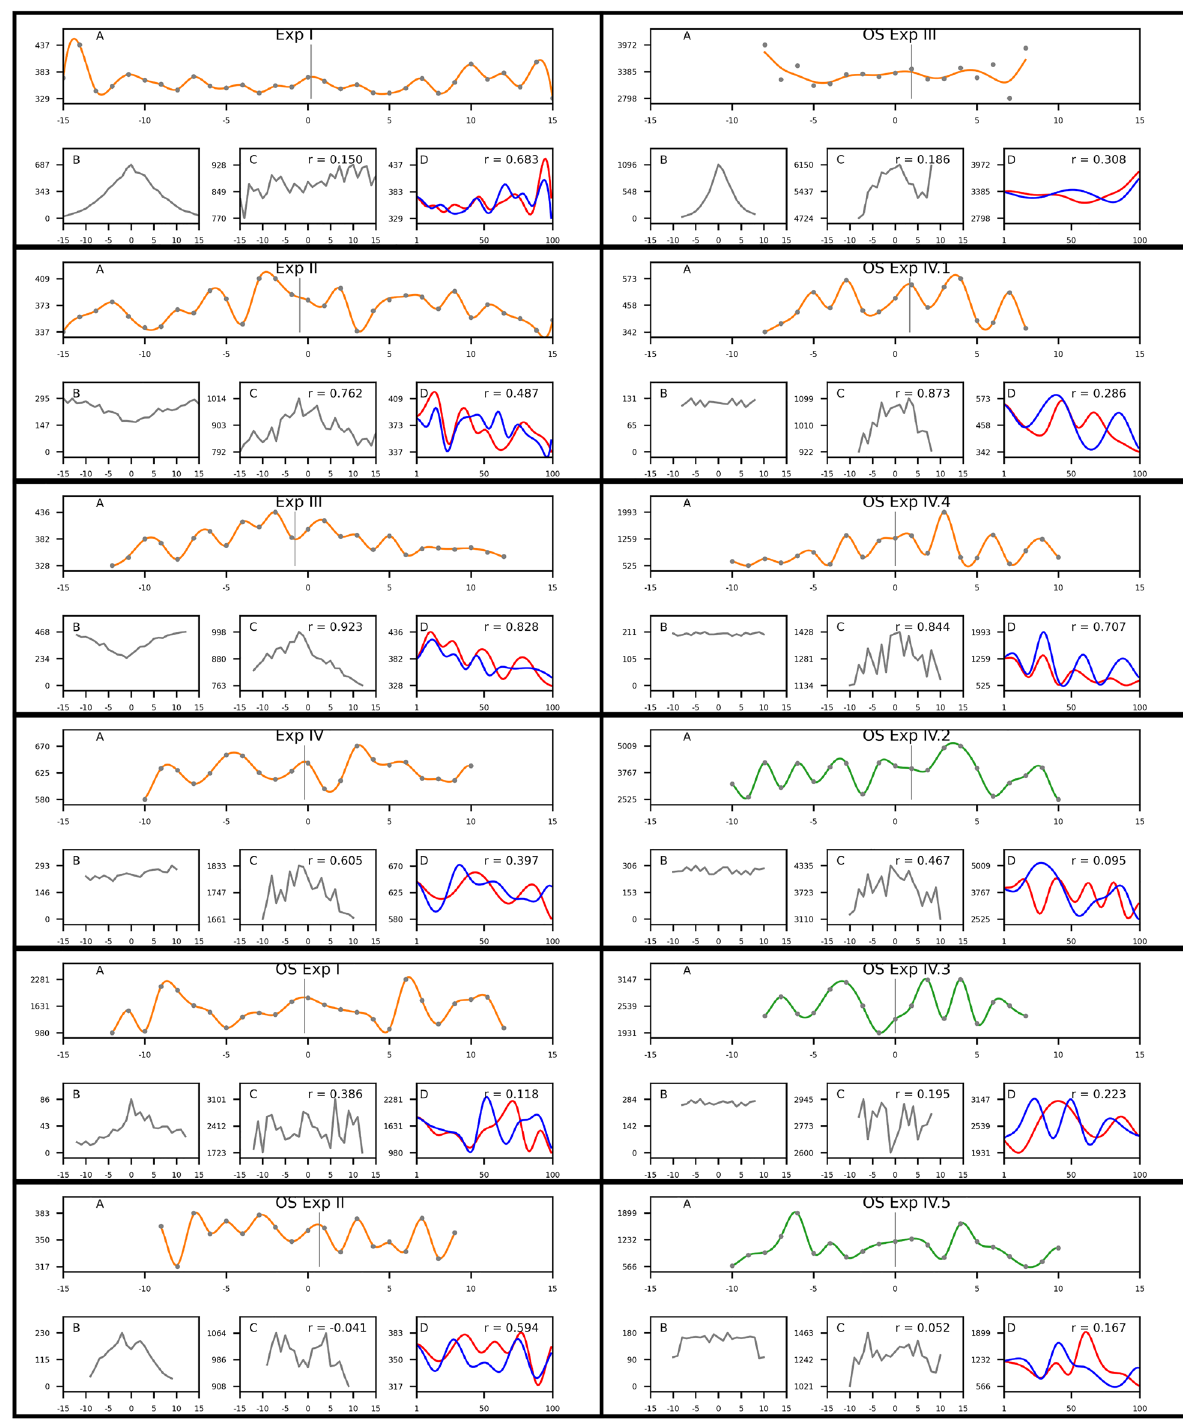
Figure 1. (Top to bottom, then left to right) Panels for the Standard Deviations ( A ), Counts ( B ), Averages ( C ) and superimposed Standard Deviations ( D ) of the response times (in milliseconds, vertical axes) plotted by the difference between the actual number of dots and the estimate (horizontal axes) in the eight experiments. Panel ( D ) shows the interpolated standard deviations for the two arms (positive [blue] and negative [red] differences, interpolated with resolution 100 points) and the correlation coefficient for the two arms of the plot. The grey line near the middle in panels A indicates the axis of symmetry used to separate the two arms. The r values in panels D in the first 9 plots (orange) are mostly moderate to high due to the symmetry of the plot, with the exception of OS Exp I where the wave-like patterns are somewhat misaligned, while the r values in the last 3 plots (green) are low due to asymmetry of the